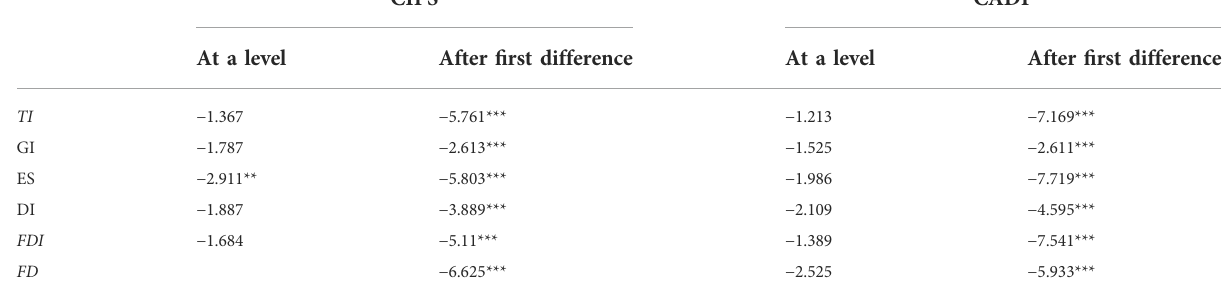
TABLE 2 Results of the second-generation unit root test.